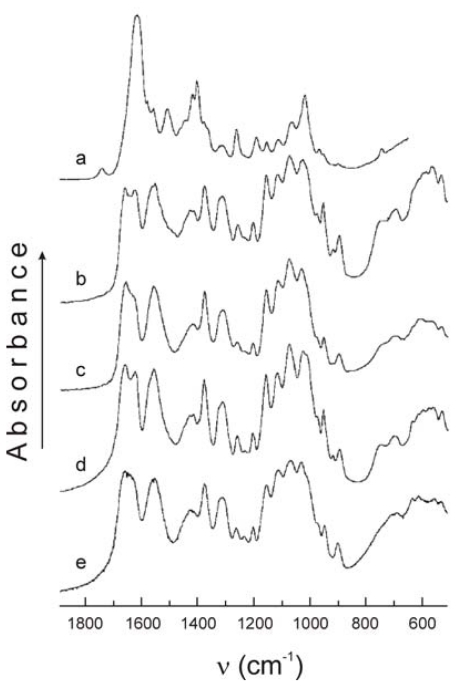
Comparison of IR spectra (shown as absorbance) of α- and β-chitin recorded using different sampling techniques. For α-chitin: (a) ATR on film, (b) DRIFT on powder, (c) Standard transmission on film, (d) Standard transmission on KBr pellet. For β-chitin: (e) Standard transmission on KBr pellets. Reprinted from Polymer 42, 2001, Brugnerotto, J., Lizardi, J., Goycoolea, F.M., Argüelles-Monal, W., Desbrières, J., Rinaudo, M., An infrared investigation in relation with chitin and chitosan characterization, 3569–3580, Copyright (2010), with permission from Elsevier [129].